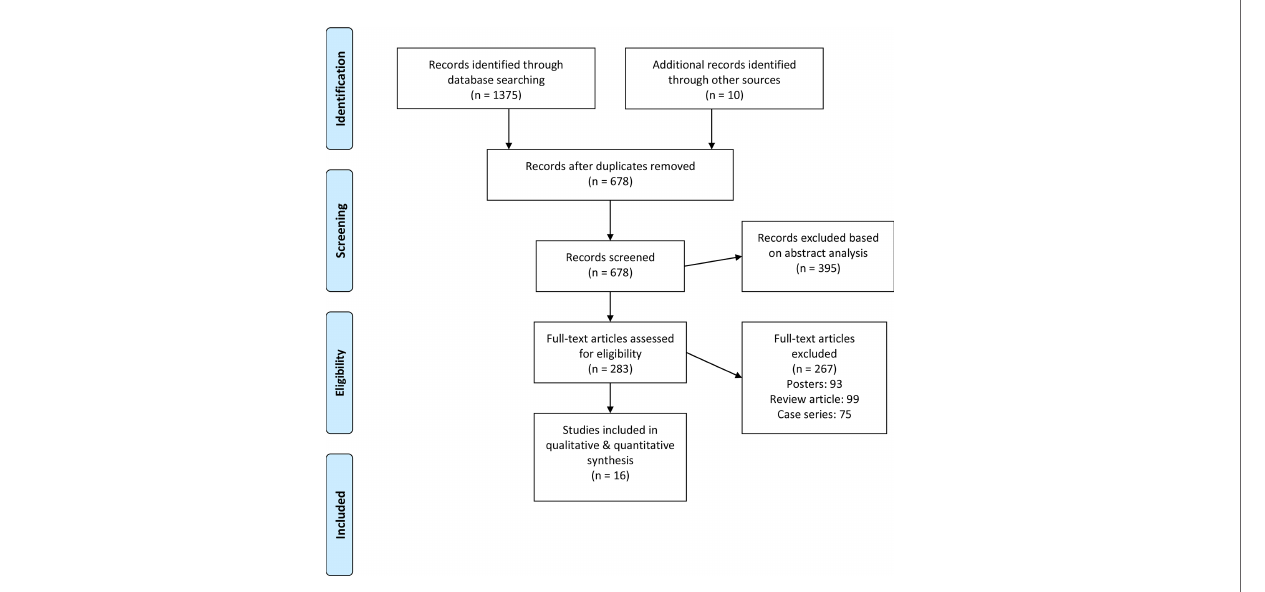
FIGURE 1 | Illustrating the PRISMA fl